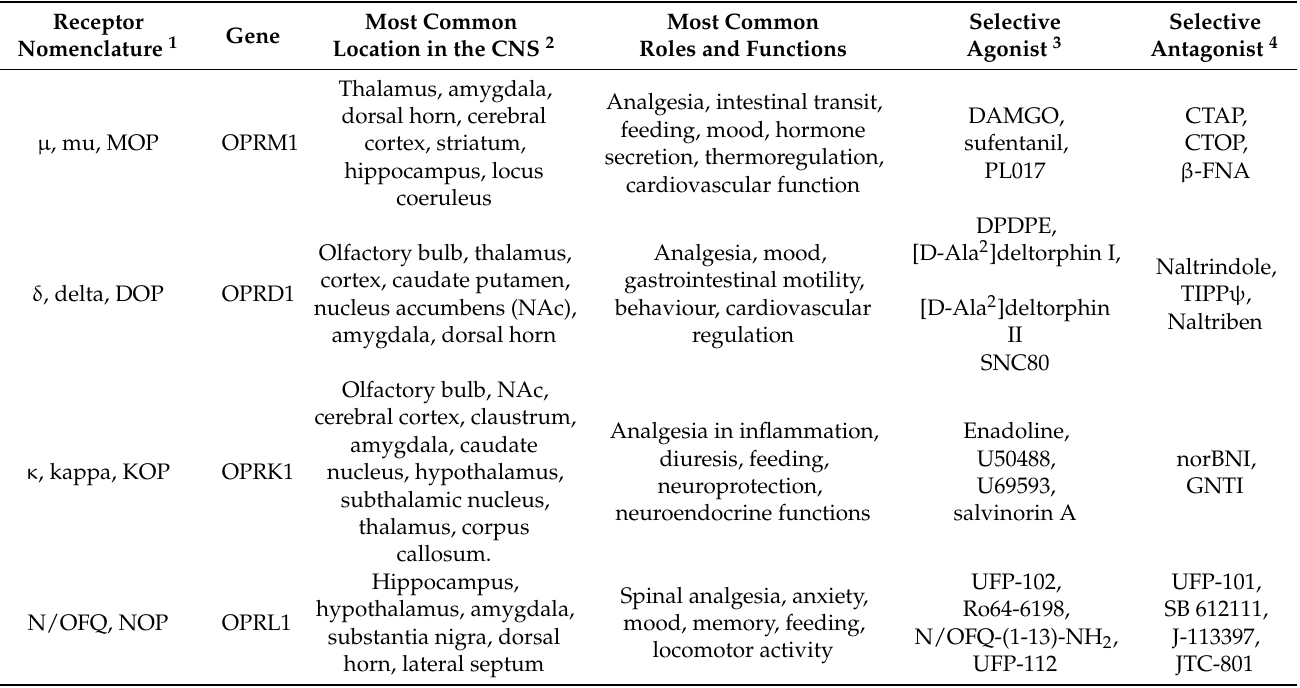
Table 1. Major types of opioid